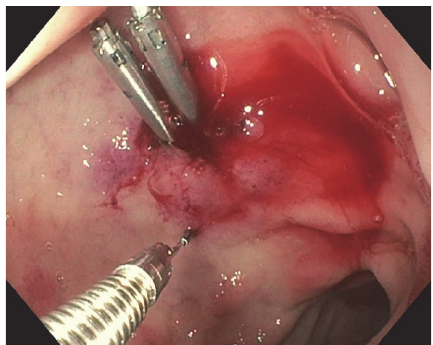
Figure 2: Two endoclips applied to the bleeding